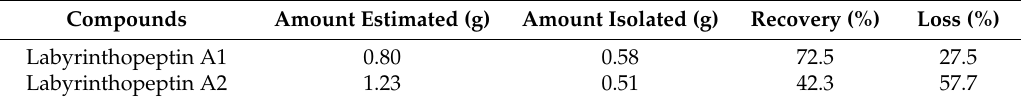
Table 3. Overall-recovery of labyrinthopeptins A1 and A2 from the isolation and separation process.